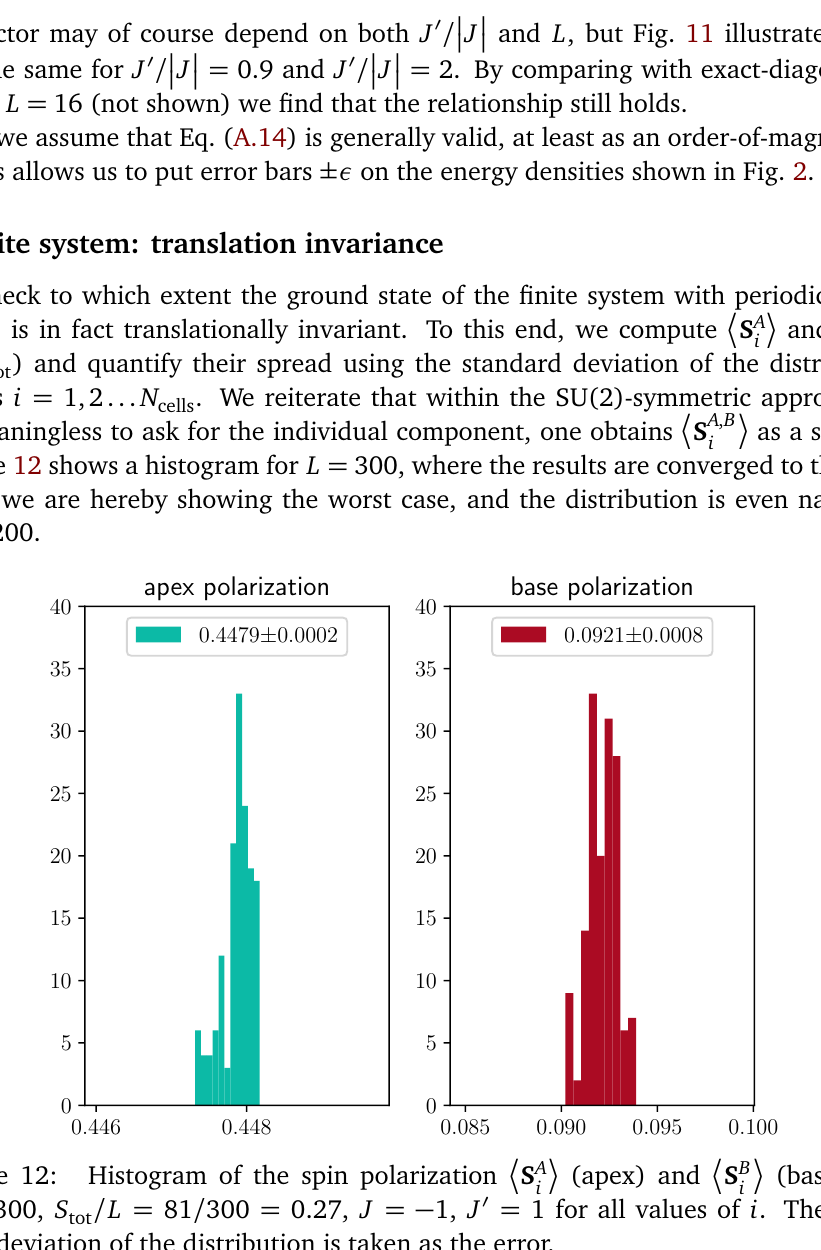
Figure 12: Histogram of the spin polarization / L = 81 / 300 = 0.27, J = − 1, J ′ = 1 for all values of i . The stan- L = 300, S tot dard deviation of the distribution is taken as the